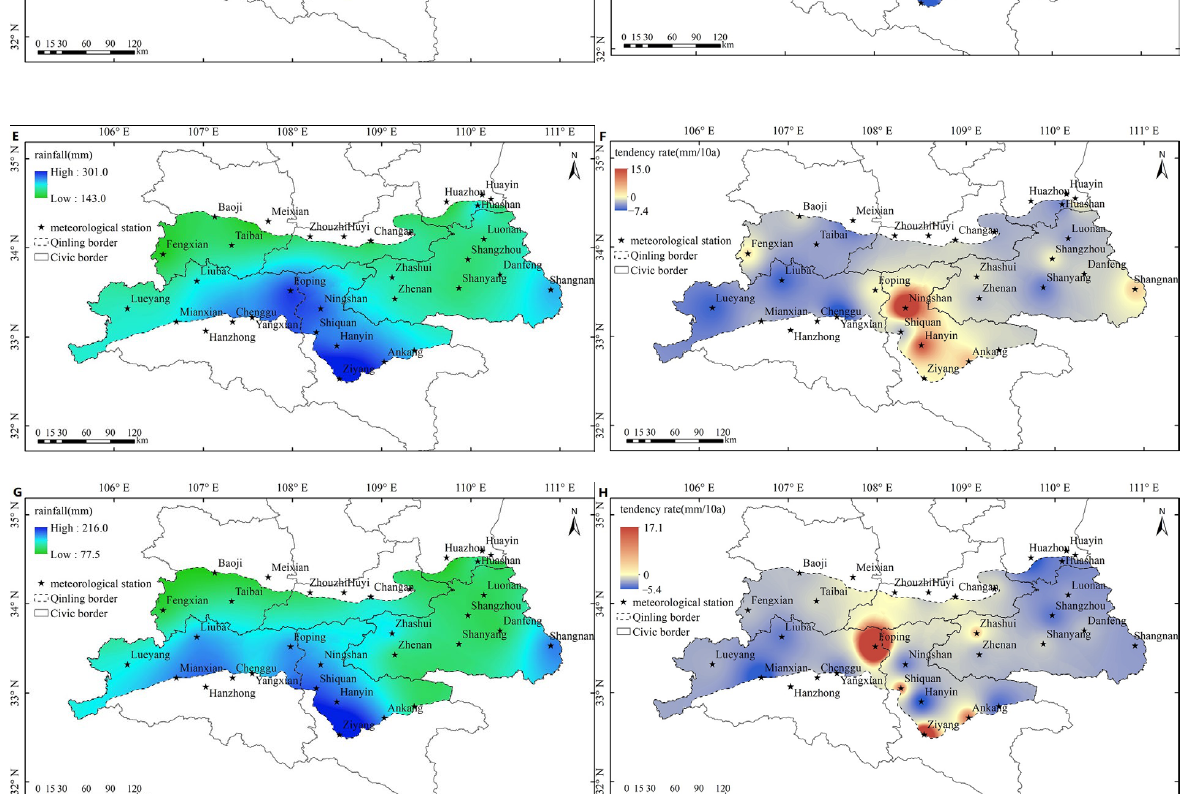
Figure 6. As in Figure 5A, but for LR ( A ), MR ( C ), HR ( E ), and TR ( G ) (unit: mm). As in Figure 5B, but for LR ( B ), MR ( D ), HR ( F ), and TR ( H ) trends (unit: mm/10a).